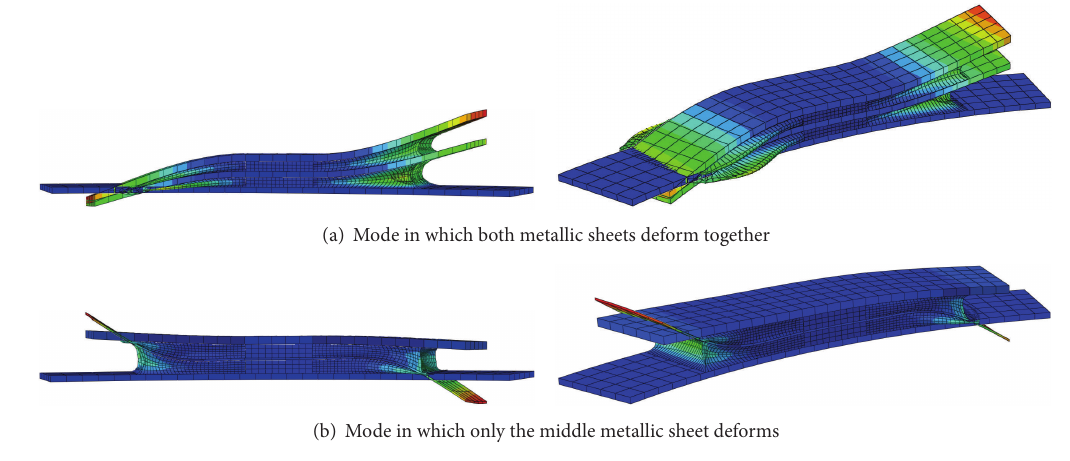
Figure 10: Different modal shapes.